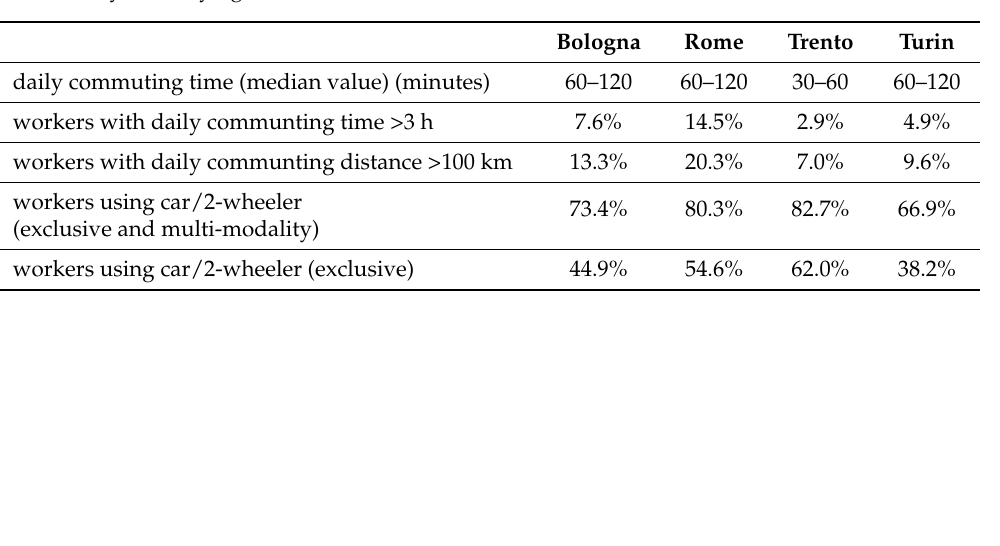
Table 1. Key mobility figures for workers in the four